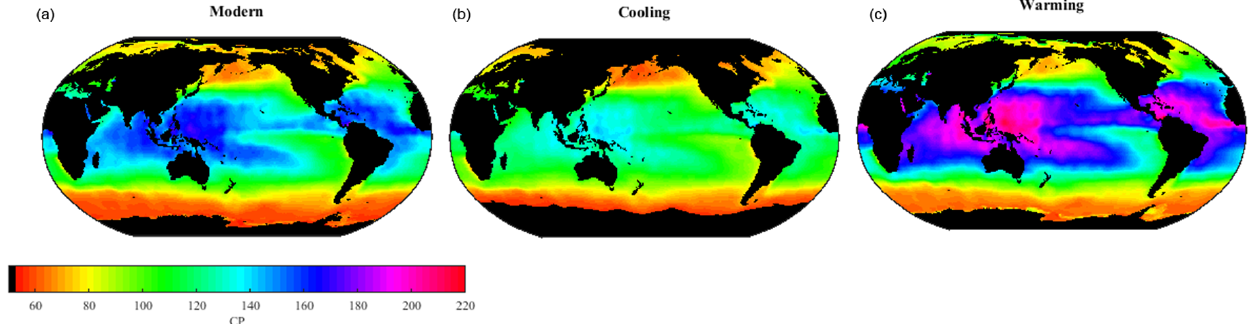
Figure 7. Predicted C : P ratios in the global ocean in differing climatic regimes. (a) C : P ratio under modern ocean conditions. Large differences in C : P are predicted between distinct types of ocean biome, with low C : P in equatorial upwelling regions and subpolar gyres, and high C : P in subtropical gyres. Regional differences between biomes of similar type are observed as well, with the low-phosphorus Atlantic having a higher C : P than the Pacific. (b) C : P ratio under cooling temperature conditions ( − 5 ◦ C from the modern ocean). (c) C : P ratio under warming temperature conditions ( + 5 ◦ C from the modern ocean). Each 5 ◦ C change leads to a shift of 15% in the mean C : P ratio of organic